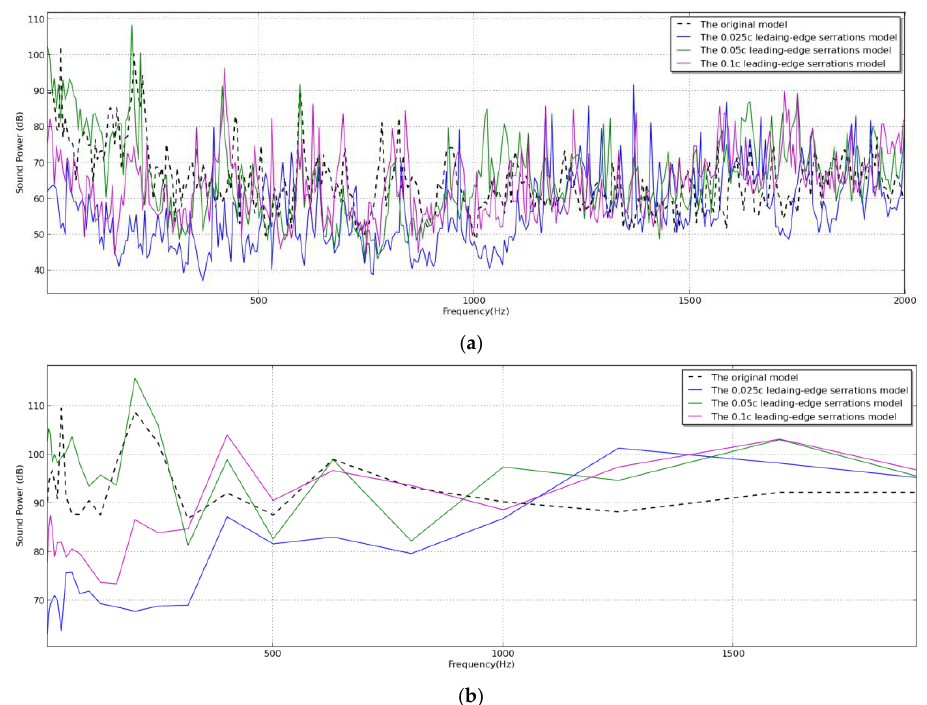
Figure 167. The curves of sound radiation power from the models with leading-edge serrations of different amplitudes. ( a ) The narrow band; ( b ) The one-third octave band. different amplitudes. ( a ) The narrow band; ( b ) The one-third octave